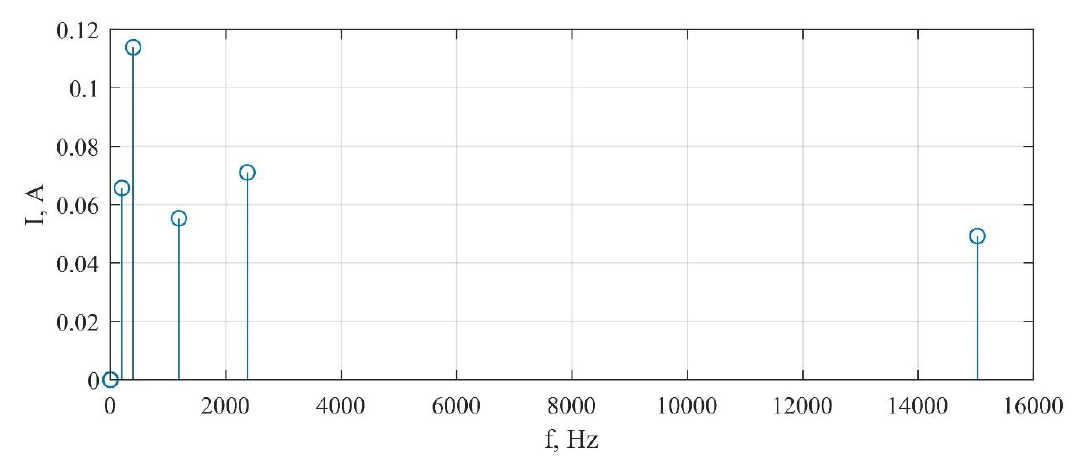
Figure 1. Spectral characteristic of the equivalent current